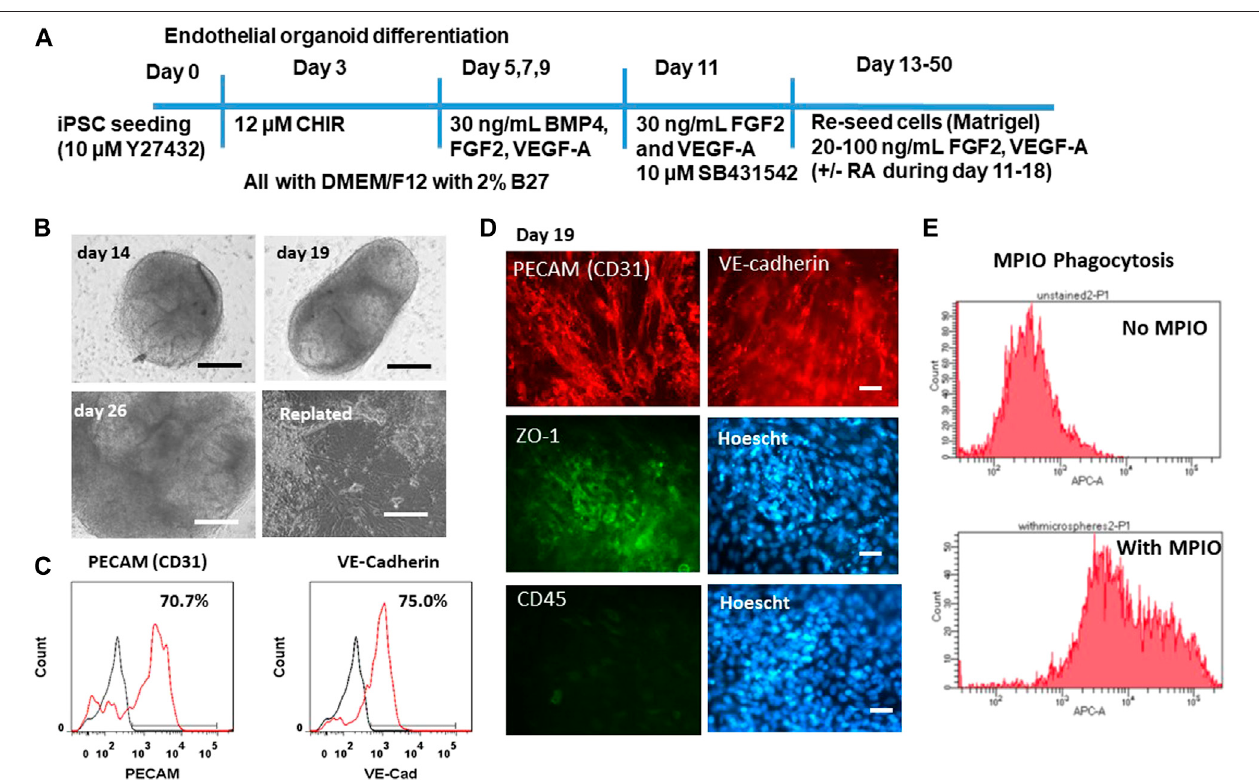
FIGURE 3 | Characterization of endothelial cells derived from iPSK3 cells (iECs). (A) Schematic of protocol for differentiation of endothelial cells from iPSK3 cells. Brain-speci fi c endothelial cells receive retinoic acid (RA) addition on day 11, 13, and 15. CHIR: CHIR99021. (B) Phase contrast images for the derived endothelial organoids at day 14, 19, and 26 as well as the replated cells. Scale bar: 200 µm. (C) Flow cytometry histograms for endothelial cell markers PECAM (CD31) and VE- cadherin. Black line: negative control; Red line: marker of interest. (D) Fluorescent images for endothelial cell markers PECAM (CD31), VE-cadherin, and ZO-1. CD45isahematopoieticcellmarker.CellnucleiwerecounterstainedwithHoescht. Scalebar:25 µm. (E) PhagocytosisabilityofthereplatediECs(day25).Thereplated cells were exposed to MPIO at the concentration of 5 μ g Fe/mL for 24 h. The cells were then harvested and fi xed. The MPIO+ cells (Alexa 647) was quanti fi ed by fl ow